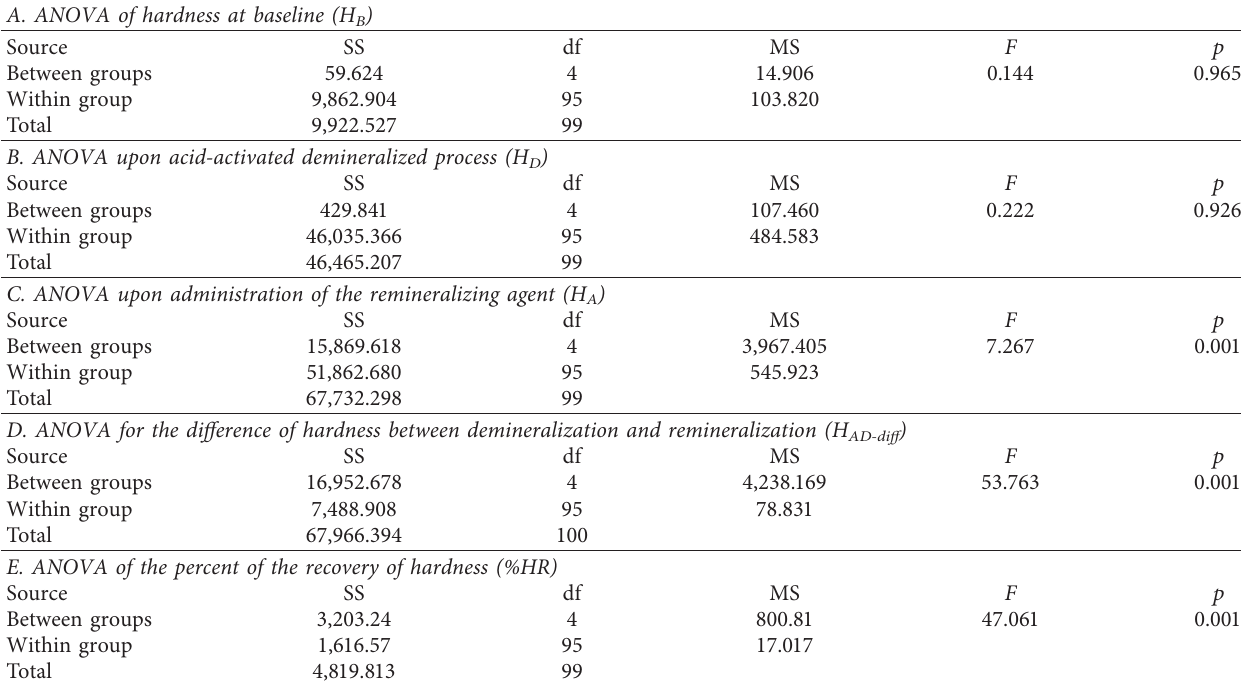
Table 3: Analysis of variance (ANOVA) of hardness at baseline ( H B ), hardness upon demineralized process ( H D ), hardness upon an applied remineralizing agent ( H A ), hardness difference determined between after demineralization and after remineralization ( H AD-diff � H A − H D ), and percentage of hardness recovery (%HR) after applied remineralizing agents ( H A ) compared to demineralization ( H D